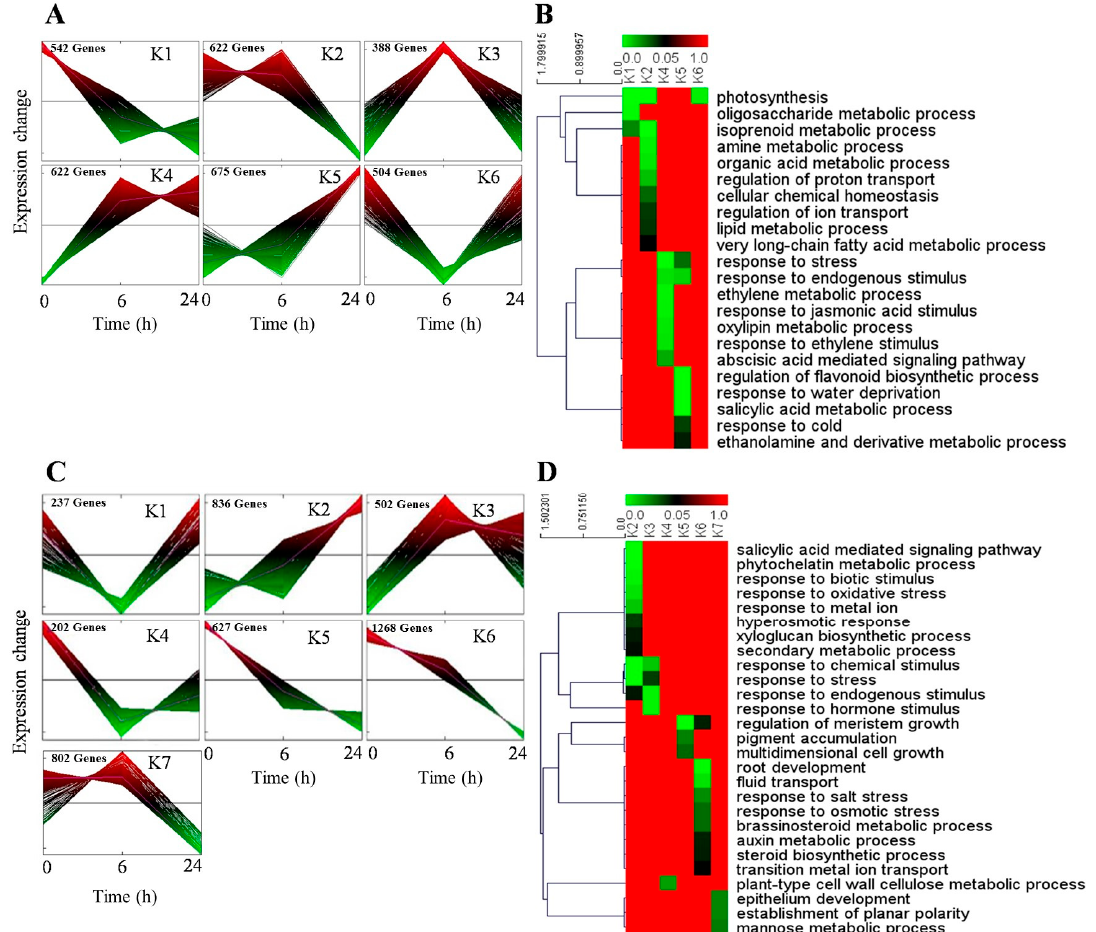
Figure 3. Expression profiles and enriched metabolic or signal transduction pathways of DEGs. ( A ) Expression profiles of DEGs in shoots under six and 24 h sorbitol treatment. The transcripts per million (TPM) values were transformed into z-scores, the red indicate higher expression levels and the green indicate lower expression levels; ( B ) enriched metabolic or signal transduction pathways of DEGs in shoots. The green and red color indicate the p value of significantly enriched pathways, green ( p = 0) indicate the dominantly enriched pathway; ( C ) expression profiles of DEGs in roots under 6 and 24 h sorbitol treatment. The TPM values were transformed into z-scores, the red indicate higher expression levels and green indicate lower expression levels; ( D ) enriched metabolic or signal transduction pathways of DEGs in roots. The green and red color indicate the p value of significantly enriched pathways, green ( p = 0) indicate the dominantly enriched pathway.